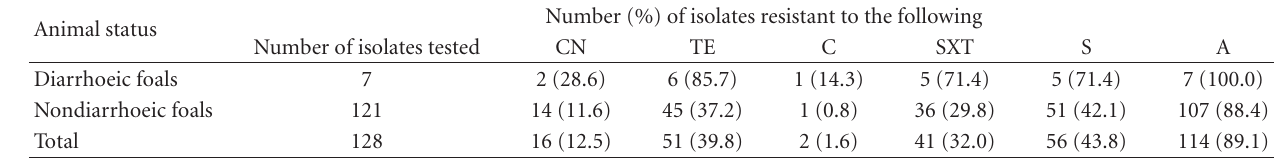
Table 2: Frequency of resistance to antimicrobial agents amongst E. coli isolates.